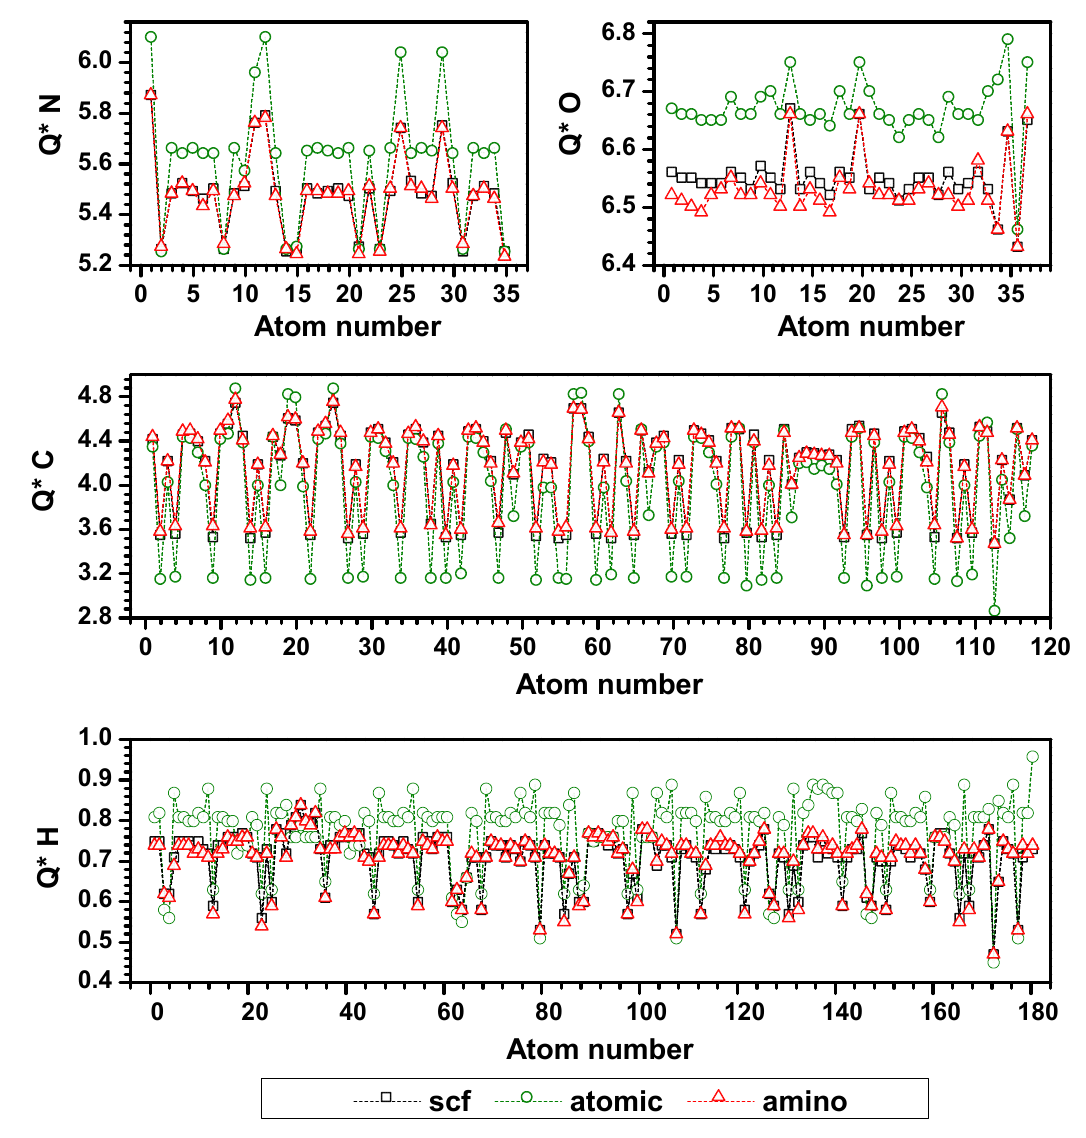
Figure 8. (Color on-line) Comparison of effective charges Q* (electrons) for each atom in chain α (I) among: Non-self-consistent field (SCF) calculation using atomic basis 2 ( green circles ), Non-SCF calculation using an amino-acid-based potential method (AAPM) ( red triangles ), and Full SCF calculation ( black squares